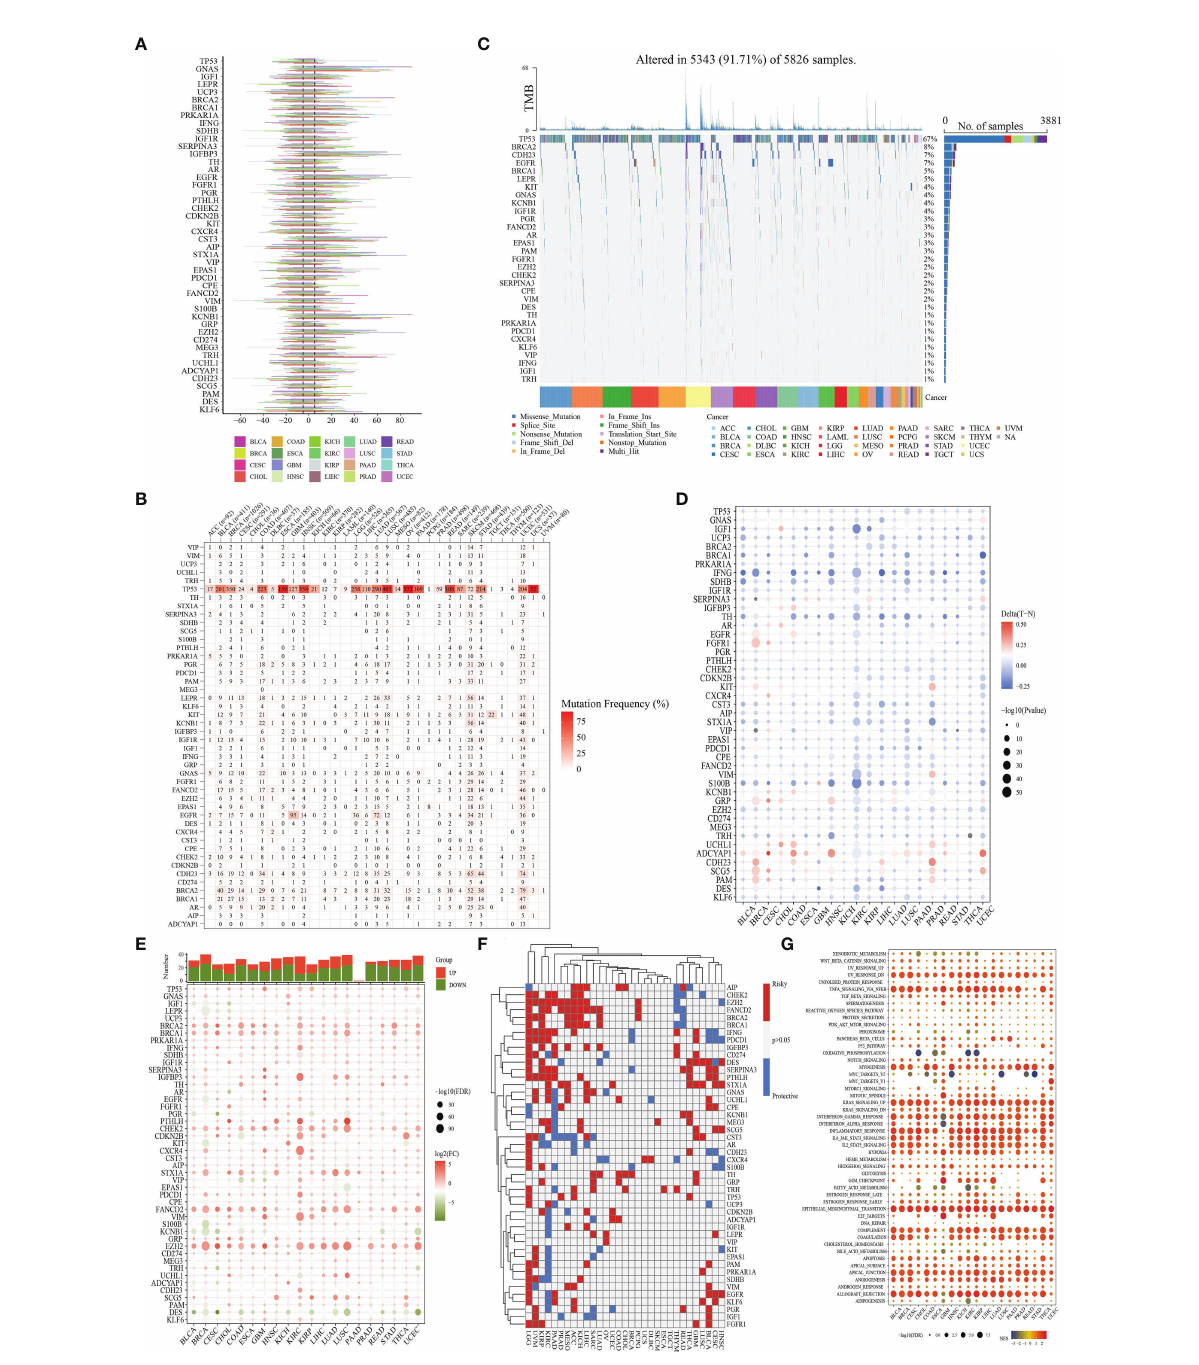
FIGURE 2 Panoramic view of nucleotide metabolism-related genes (NMNGs) in pan-cancer. (A) Histogram shows the frequency of copy number variation (CNV) for each NMNG in each cancer type. (B) Mutation frequency of NMNGs. The numbers show how many samples of a certain tumor have the matching mutant gene. “ 0 ” denotes the absence of any mutation in the gene ’ s coding region, while no number denotes the absence of any mutation in the gene at all. (C) Single-nucleotide variation (SNV) oncoplot. An oncoplot displaying the distribution of NMNG mutations and a list of SNV kinds. (D) Heatmap displays the differential methylation of NMNGs in cancers; hypermethylated and hypomethylated genes are denoted with red and blue, correspondingly (Wilcoxon rank-sum test). (E) Histogram (upper panel) and heatmap demonstrate the number of signi fi cant DEGs and the fold change and FDR of NMNGs, respectively, in each cancer. Substantially upregulated and downregulated genes are denoted with red and green, correspondingly. (F) NMNGs ’ survival pro fi les across cancers. (G) Enrichment analysis for cancer pathway signaling between tumor samples with high- and low-NMNGs